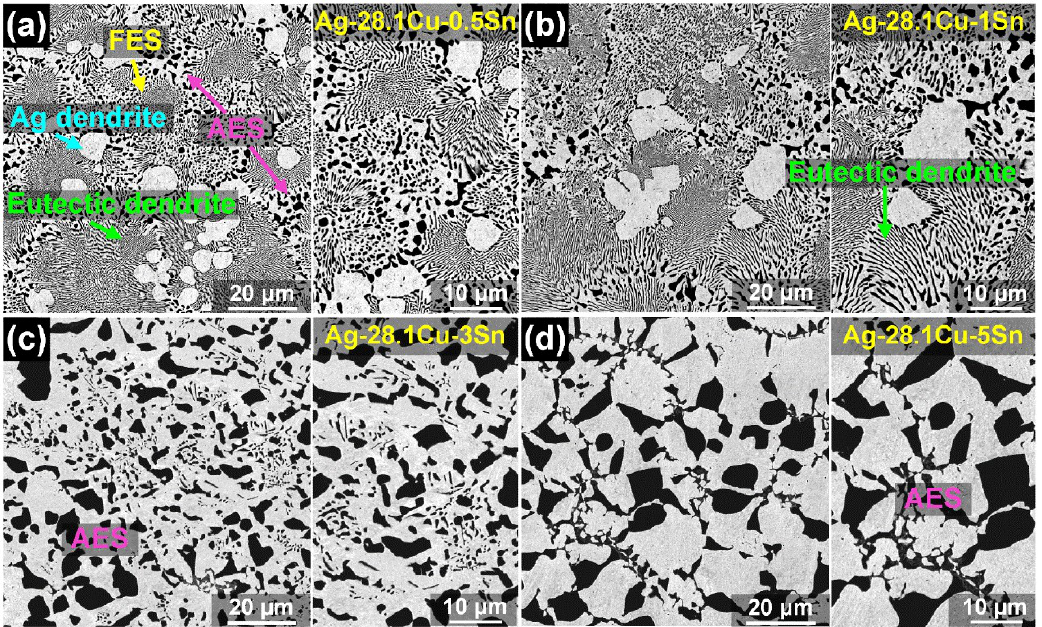
Figure 5. Eutectic morphologies in the Ag-Cu eutectic alloys solidified at 30 K/s with different Sn additions: ( a ) Ag-28.1Cu-0.5Sn, ( b ) Ag-28.1Cu-1Sn, ( c ) Ag-28.1Cu-3Sn and ( d ) Ag-28.1Cu-5Sn.